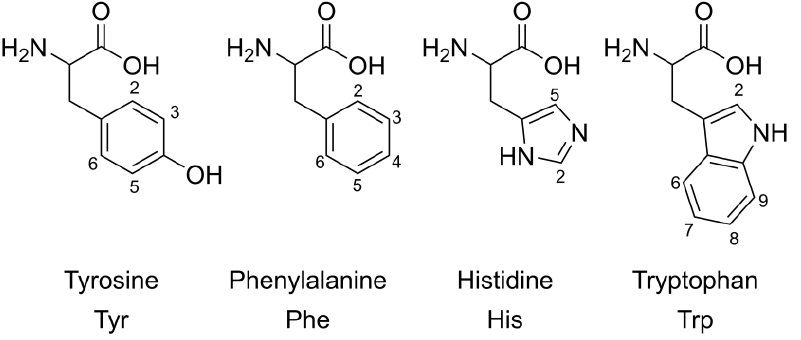
Figure 3. Structures and annotated aromatic protons of relevant amino acids (chirality and zwitter- ionic forms are not shown). Table 1. Chemical shifts and other parameters of aromatic proton signals.